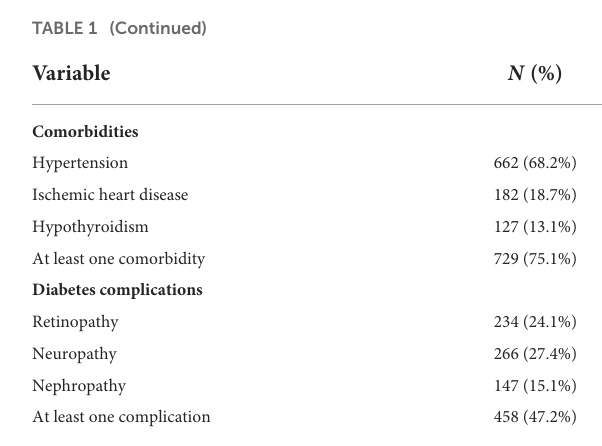
factors associated